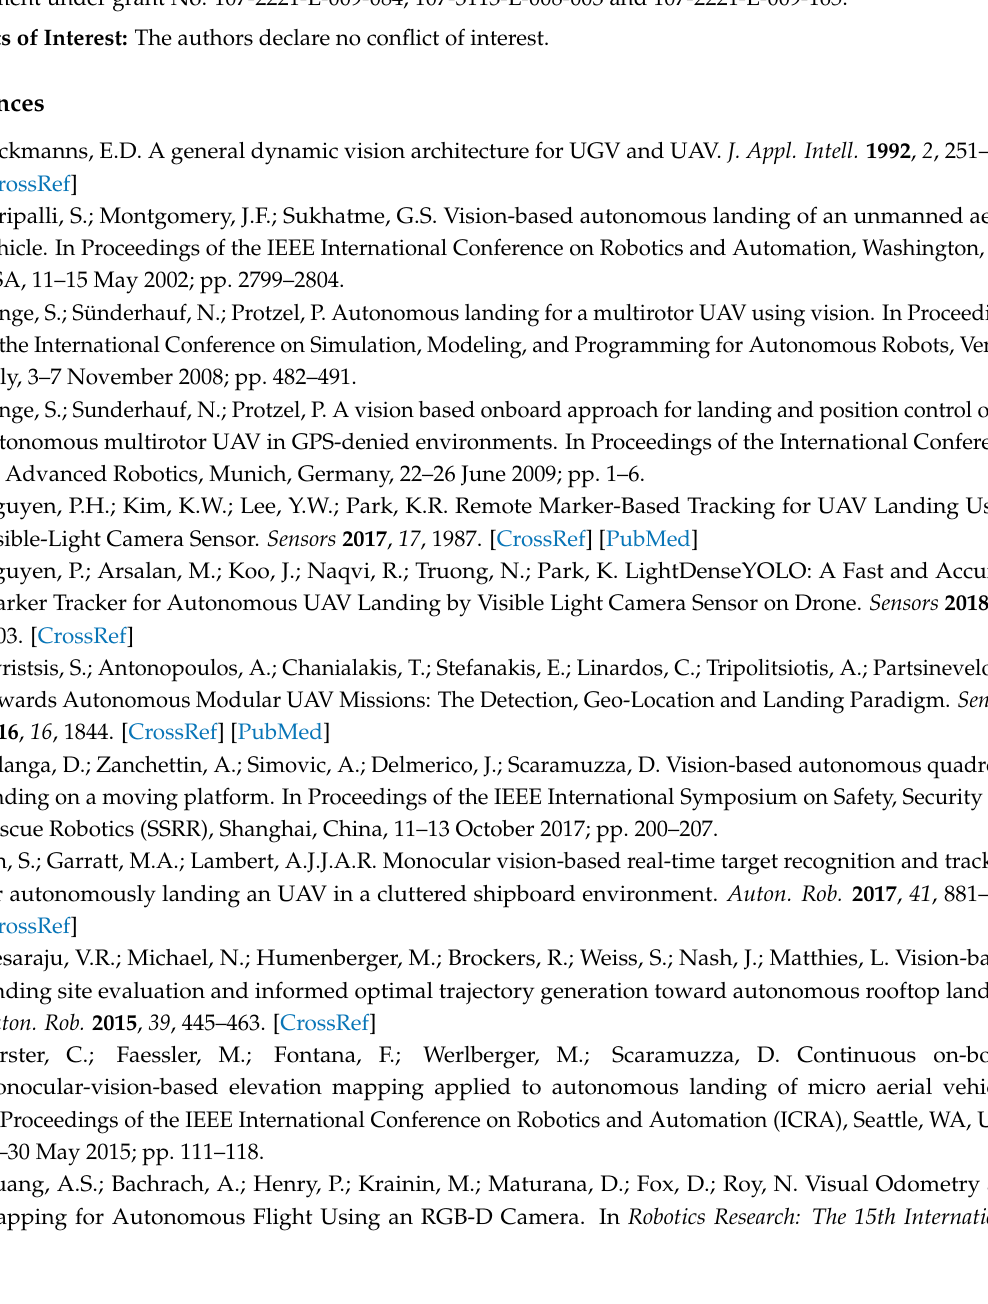
s1, Figure S1: The images used for template matching. Figure S2: Mode 1 (vision-based landing): the results associated with different initial